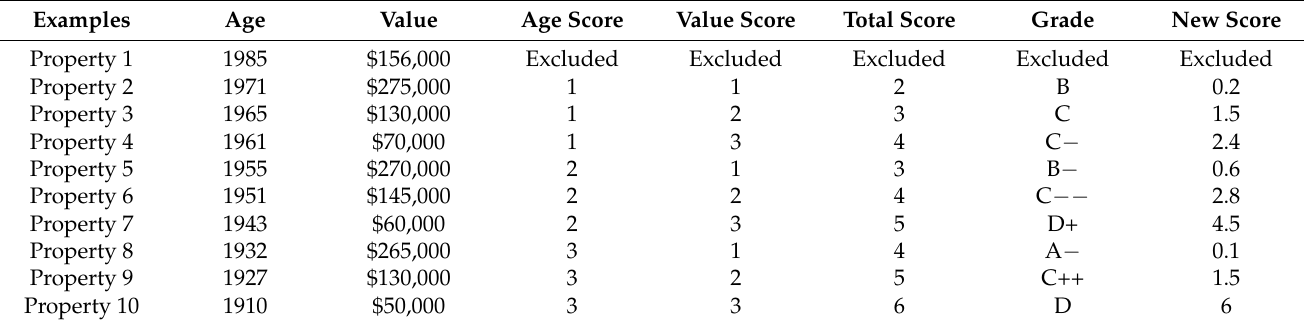
Table 1. Example of final lead risk score after risk modifier applied.